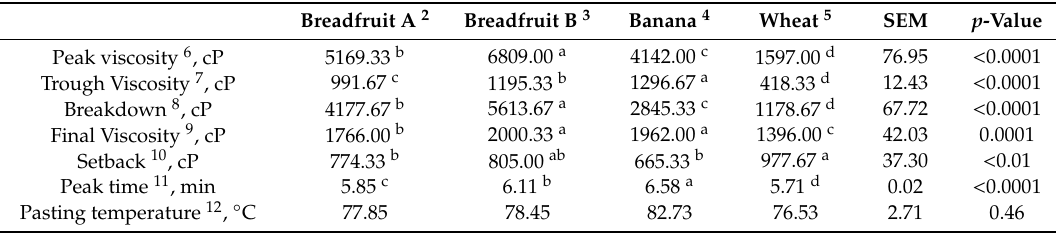
Table 5. The pasting properties of tropical flours compared with a traditional flour using RVA method #2 (maximum temperature of 130 ◦ C) 1 .